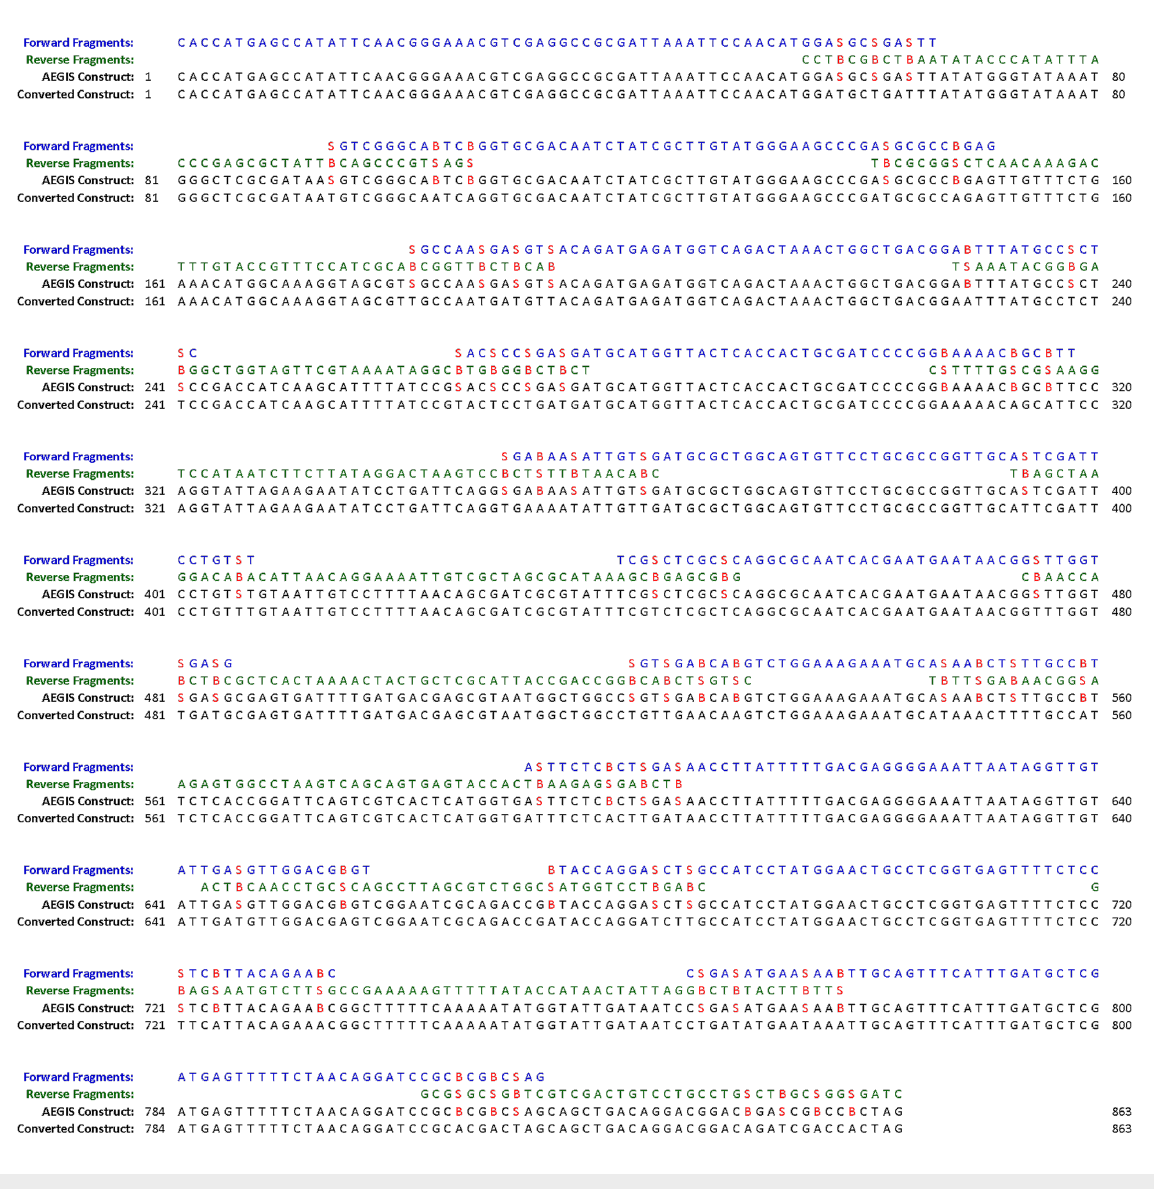
Figure 4: Representative assembly of oligonucleotides designed by OligArch built from the components of the six-nucleotide AEGIS GACT SB alphabet. The top two lines show the fragments. The line below shows the product before conversion. The bottom line shows the end product, entirely natural DNA, after conversion. This example, from [6], leads to the autonomous self-assembly of a gene that confers resistance to the antibiotic kanamycin.